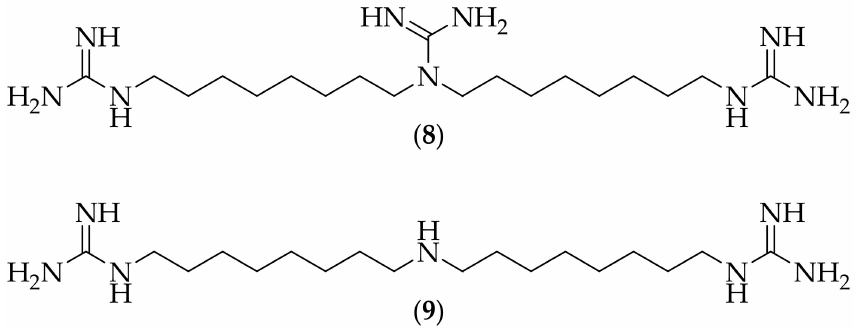
Figure 5. Guanidine-containing small molecules ( 8 ) and ( 9 ) separated from